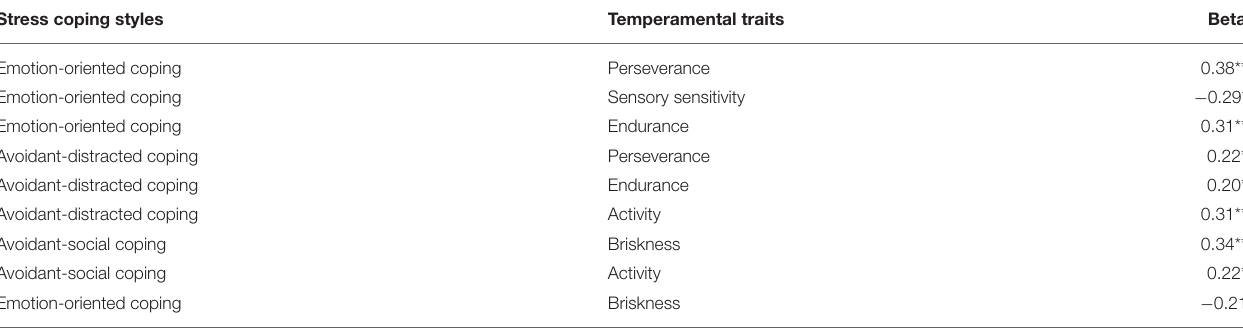
TABLE 4 | Regression weights between temperamental traits and stress coping styles acquired in path